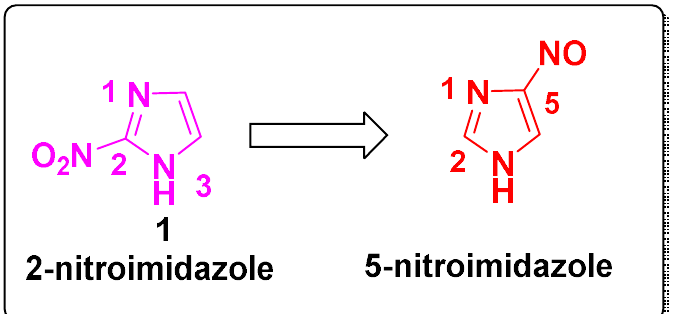
Figure 2. Chemical structure of 2-nitroimidazole and 5-nitroimidazole. The 5-nitroimidazole scaffold [6] was the starting point to the synthesis of numerous analogs, and one among such is Metronidazole 7 ((Flagyl ® , Rhône-Poulenc, France), which has shown potent anti-protozoal activity and lesser toxicity than Azomycin 1 (Figure 3) [7]. Metronidazole 7 was the first systemically active medicine against Trichomonas vaginalis and Trichomonas foetus . Currently, Metronidazole 7 is used to treat bacterial vaginosis , trichomonas, amebiasis , and non-sporing anaerobic bacterial infections caused by Bacteroids fragilis [8]. The 5-nitroimidazole moiety is well known for its broad spectrum of anti-infectious activity [9]. A specific review on the anti-infectious activity of 5-nitroimidazole